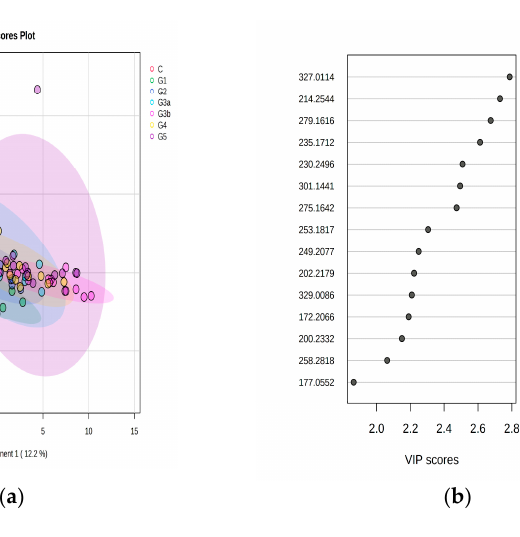
Figure 4. ( a ) PLSDA score plot representing the discrimination between group C and subgroups G1–G5 in urine samples (covariance of 19.8%). ( b ) VIP score plot for the top 15 molecules, with VIPs > 1.6. ( c ) MDA values for the top 15 molecules to be considered as potential biomarkers of progression from G1 to G5.